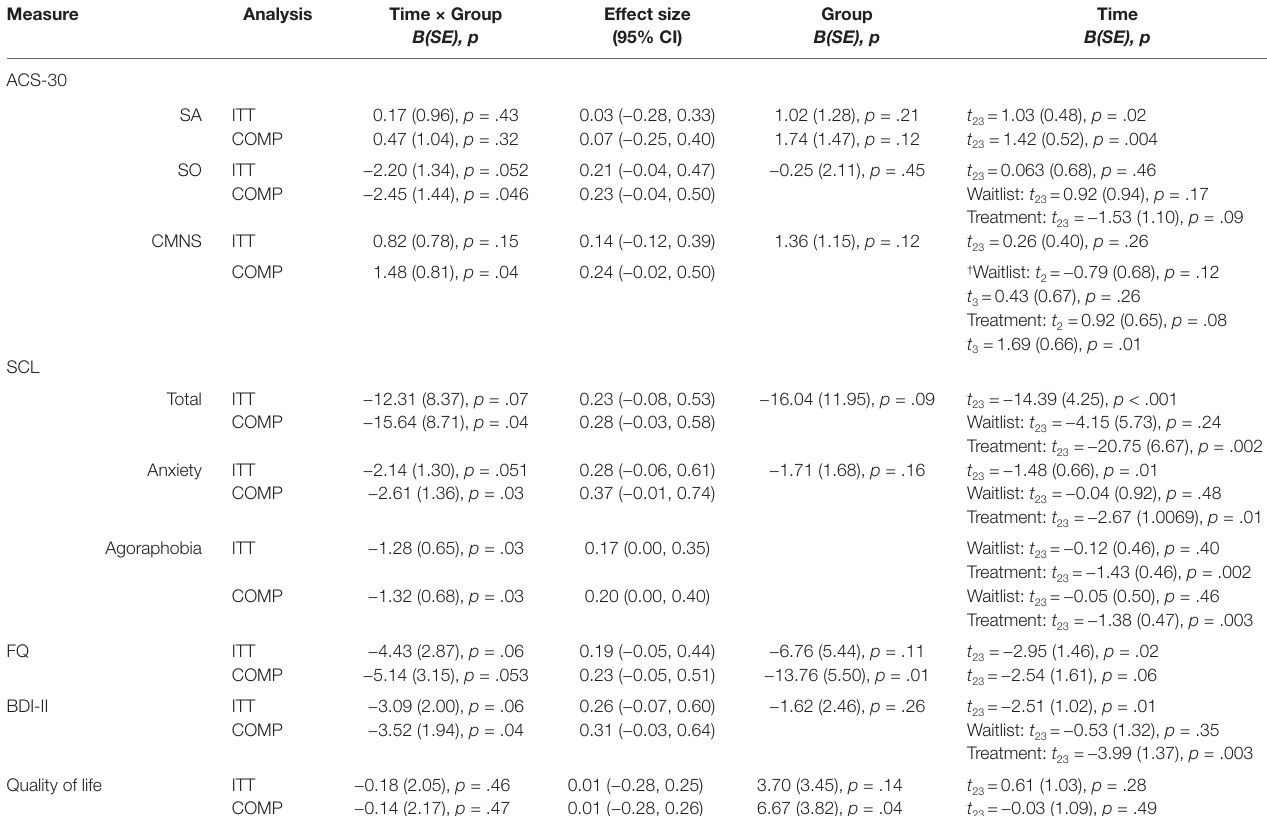
TABLE 4 | Overview of the mixed model analyses for the intention-to-treat (ITT) and completers analyses (CA). Measure